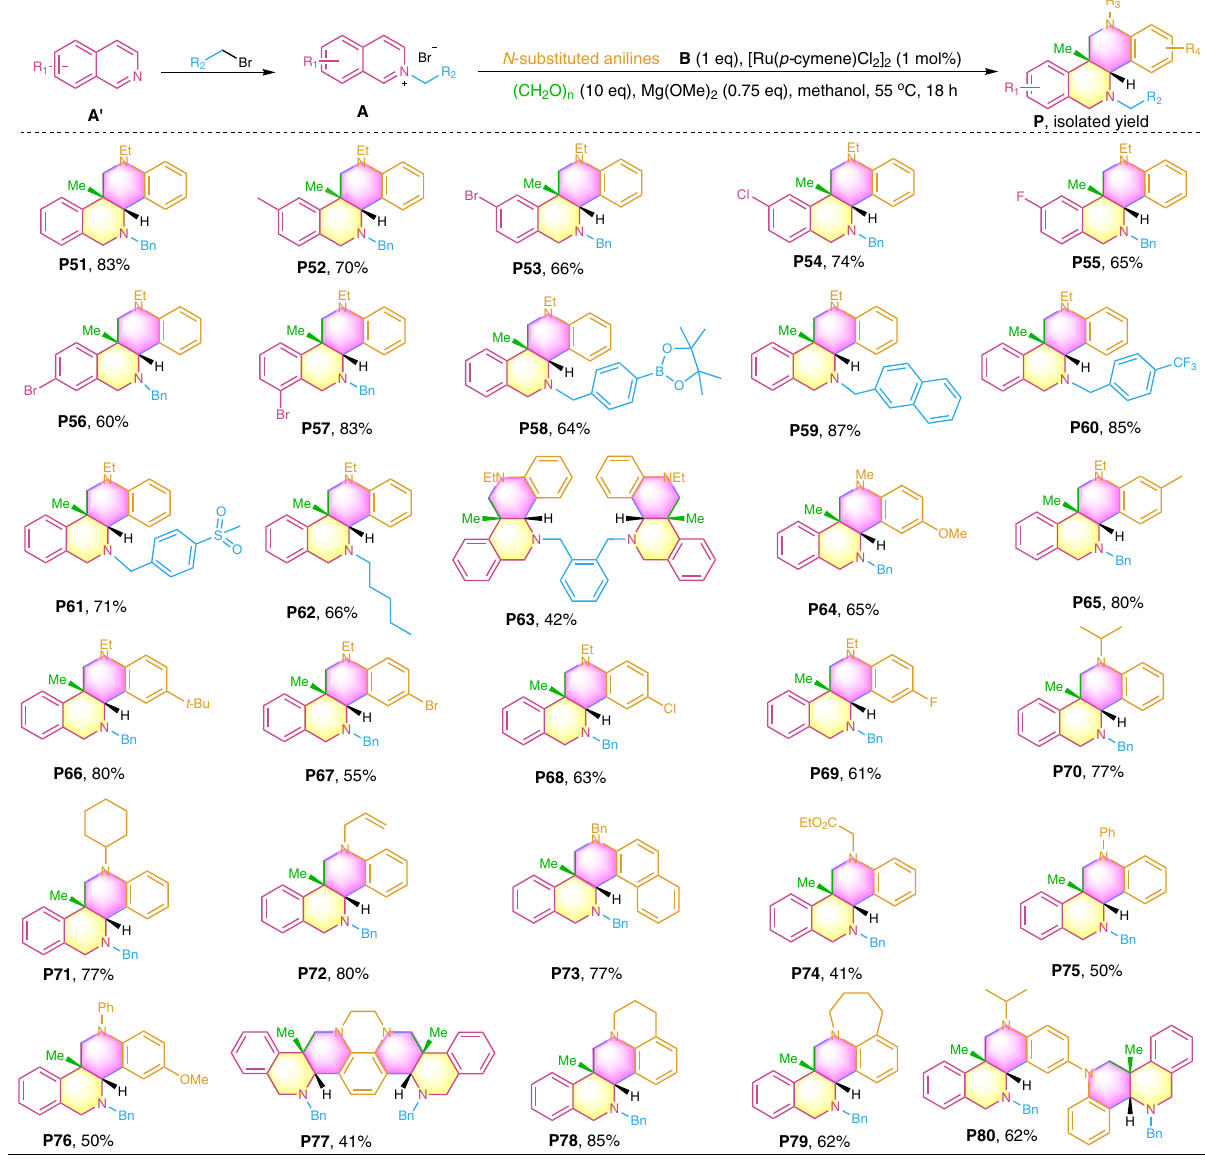
Fig. 4 Diastereoselective access to fused N-heterocycles P51 – P80 by employing various isoquinolinium salts. Reactions were conducted on a 0.2 mmol scale under the standard conditions. Isolated yields are